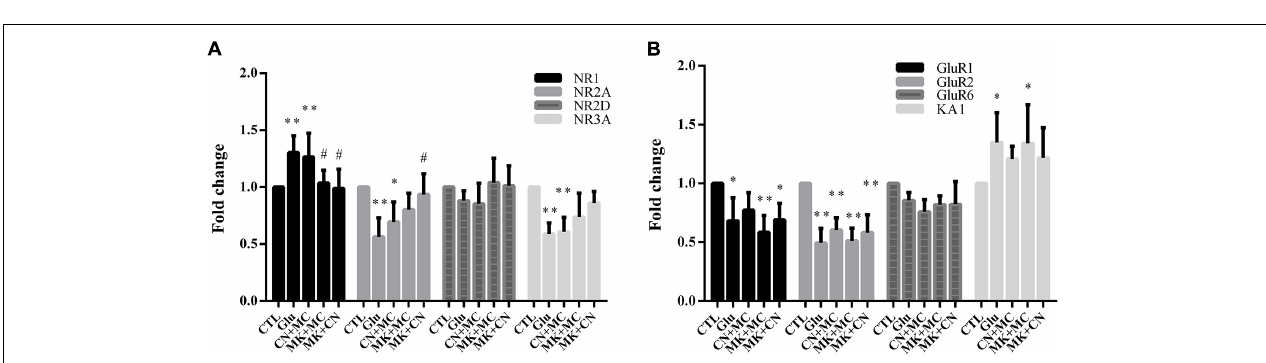
FIGURE 3 | The mRNA level of various subtypes of ionotropic glutamate receptors after antagonist and glutamate treatment. (A,B) Fold change of various subtypes of glutamate receptors mRNA level detected by real-time PCR; MK, CN, and MC were used at a concentration of 10, 10, and 50 µ M, 30 min before 15 min glutamate insult. To ensure consistency of the results, experiments were repeated four times. Data were analyzed using one-way ANOVA. ∗ p < 0.05, ∗∗ p < 0.01 vs. respective CTL group, # p < 0.05 vs. respective Glu group.